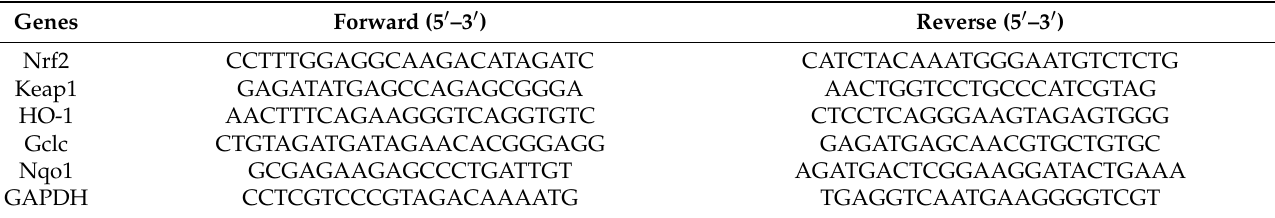
Table 1. Primer sequences used for quantitative